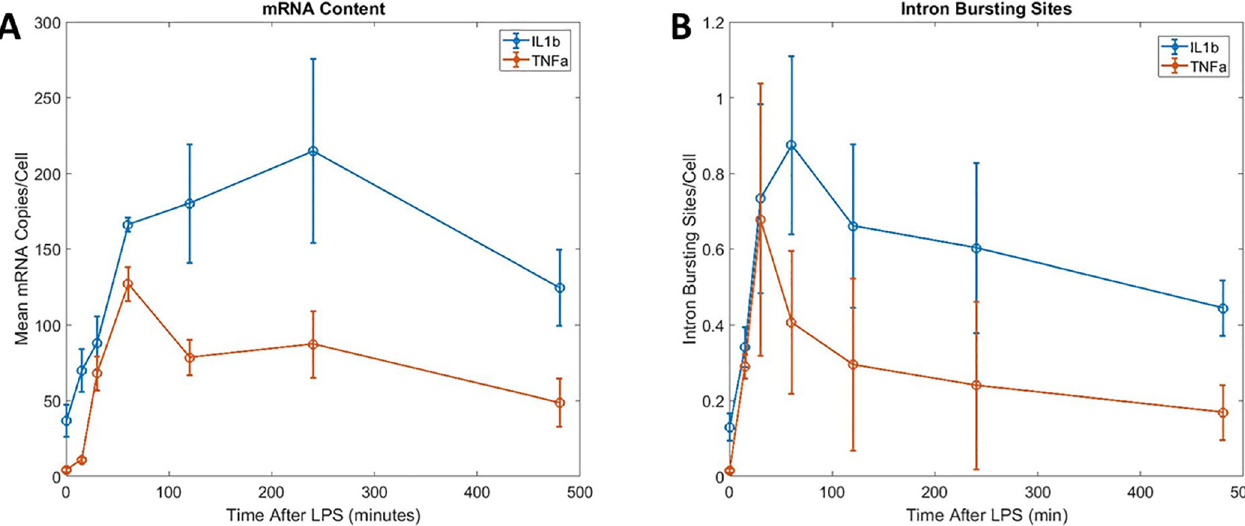
Fig 3. Mean mRNA content (A) and intron bursting sites (B) over time for IL1 β and TNF- α . Error bars are from the standard deviation of the mean measured from three or four scans (of approximately 1000 cells) over 2 wells of biological replicates. (We note that the breadth of the single cell mRNA distributions are much larger than the standard deviation of the mean shown as error bars above).